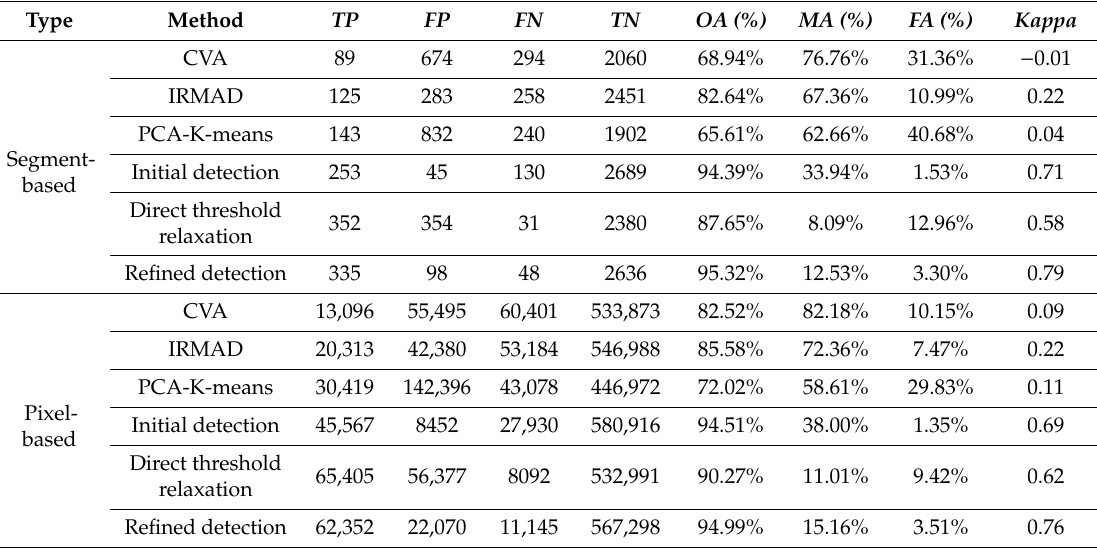
Table 3. Detection precision in area